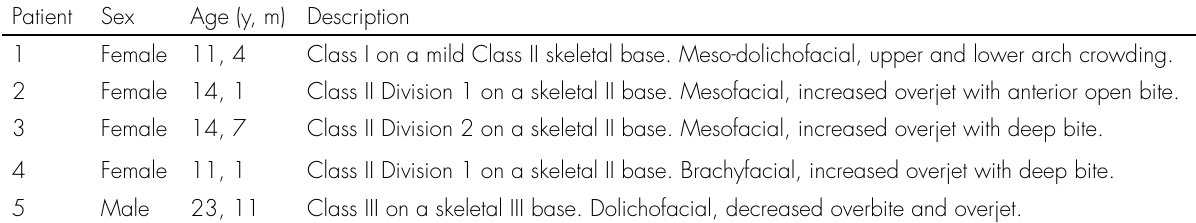
Table I. Patient age and formative diagnosis.